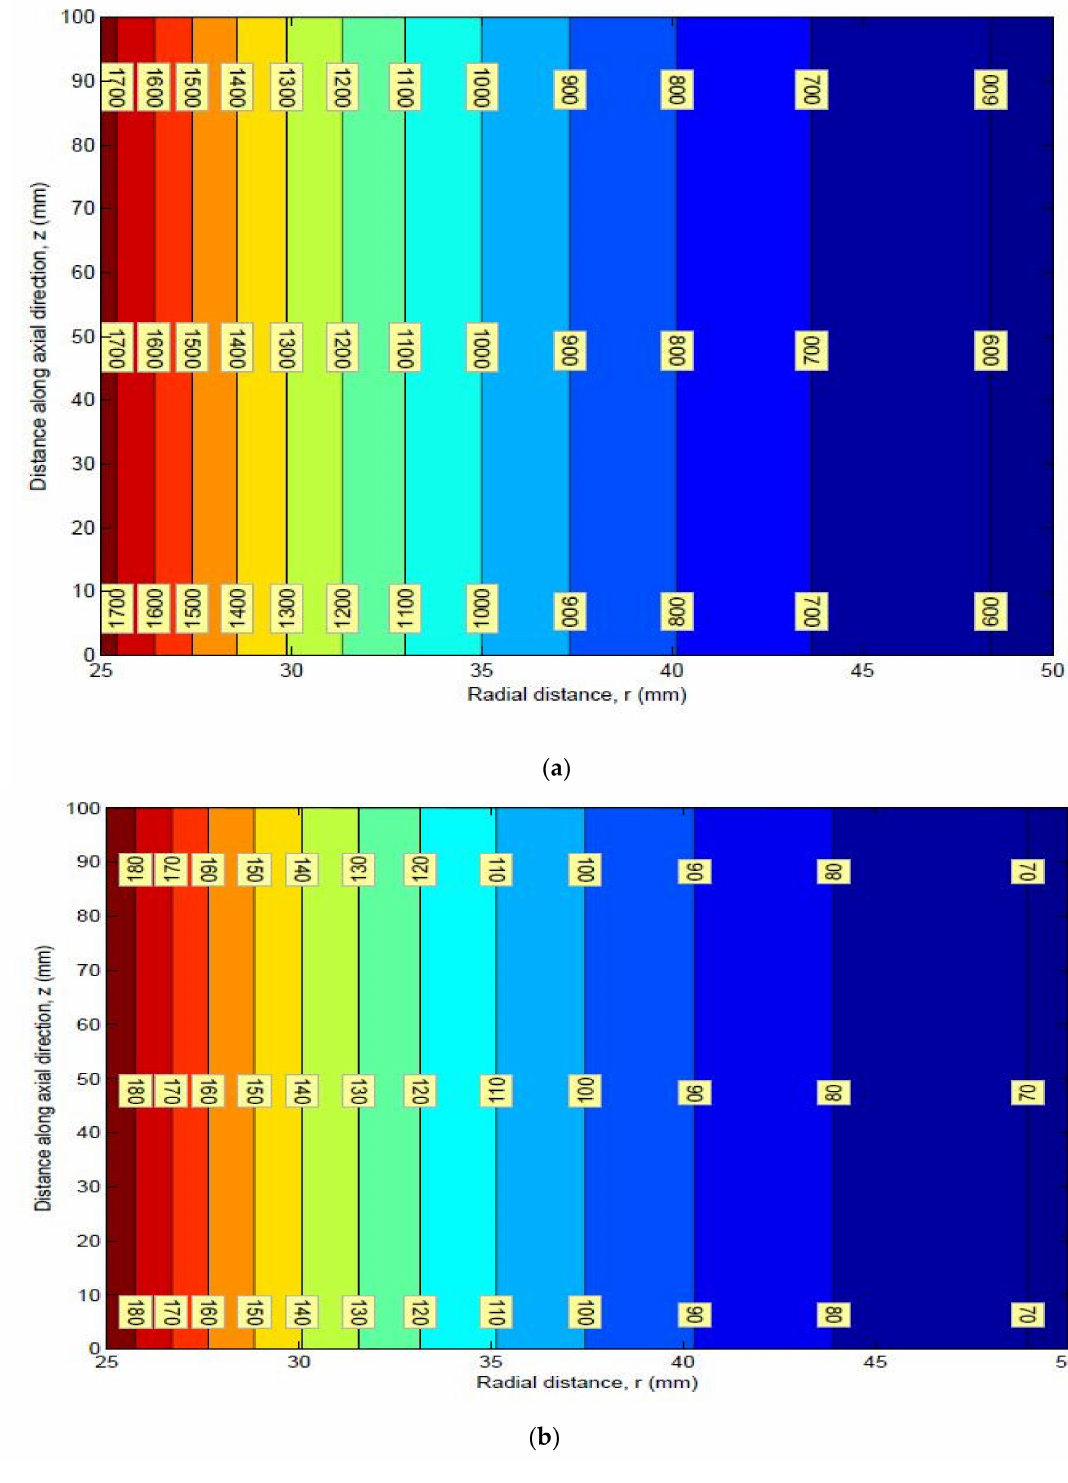
Figure 24. ( a ) Mean and ( b ) Standard deviation of Von-Mises